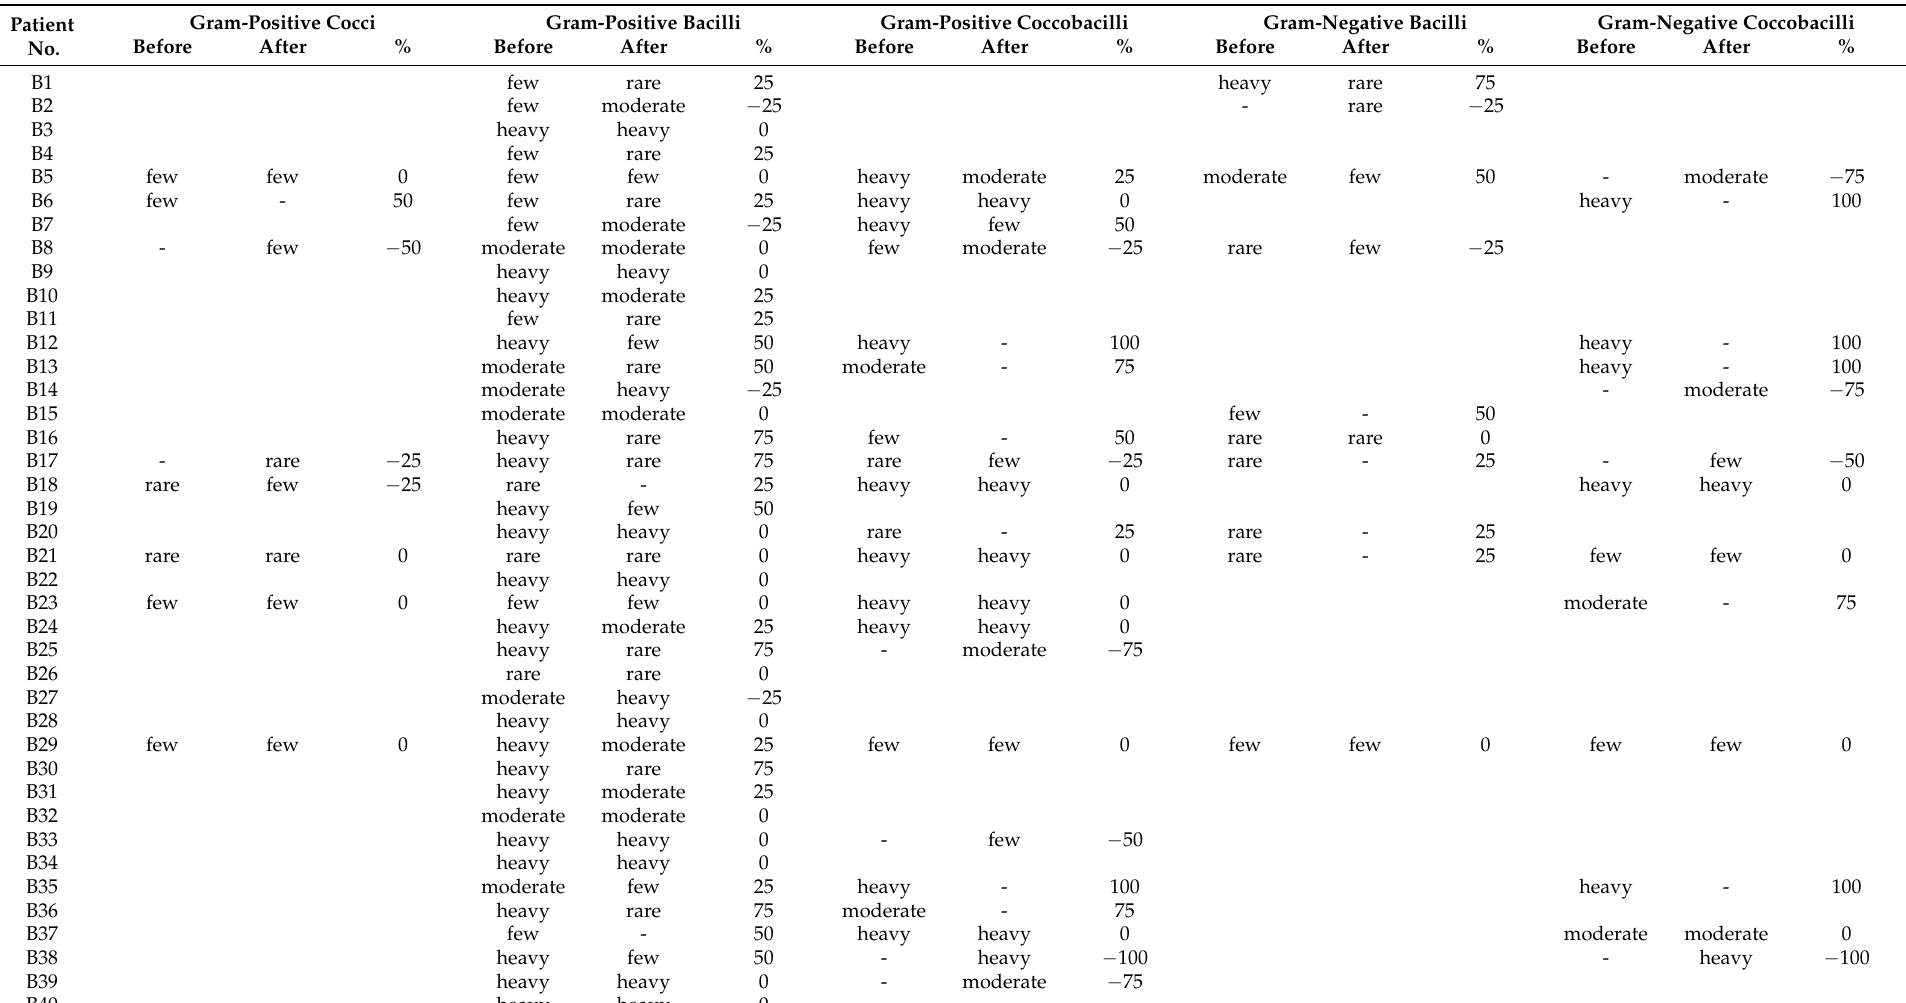
Table 3. A summary of the results of Gram stain in the betadine-treated patients. The minus ( − ) and plus (+) signs indicate the reduction and increase of bacteria,